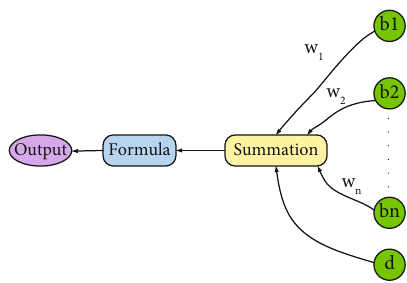
Figure 1: Structure diagram of arti fi cial